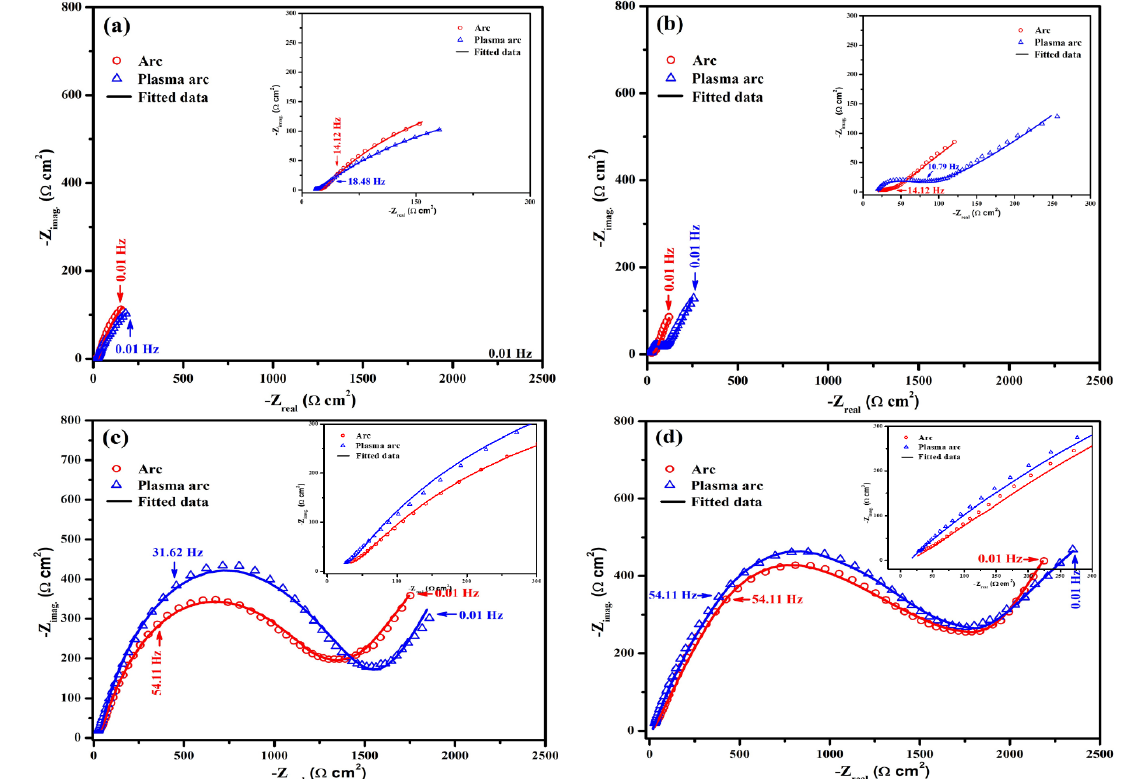
Figure 7. Complex-plane impedance plots of the Zn coatings deposited by different processes after ( a ) 1 h, ( b ) 1 d, ( c ) 13 d, and ( d ) 23 d of exposure to artificial seawater.